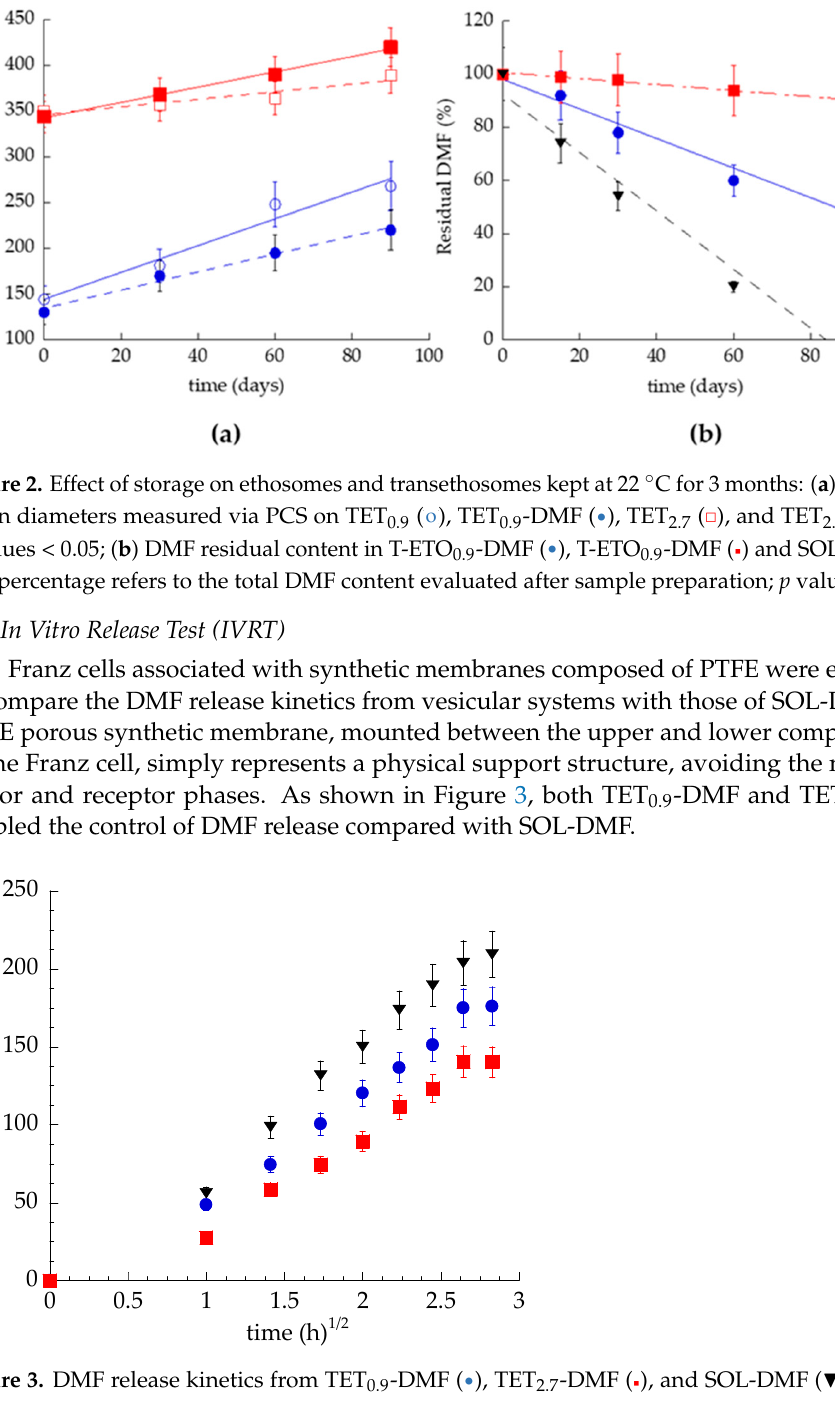
Table 3. IVRT parameters of the indicated formulations, as determined by Franz cells associated with PTFE.